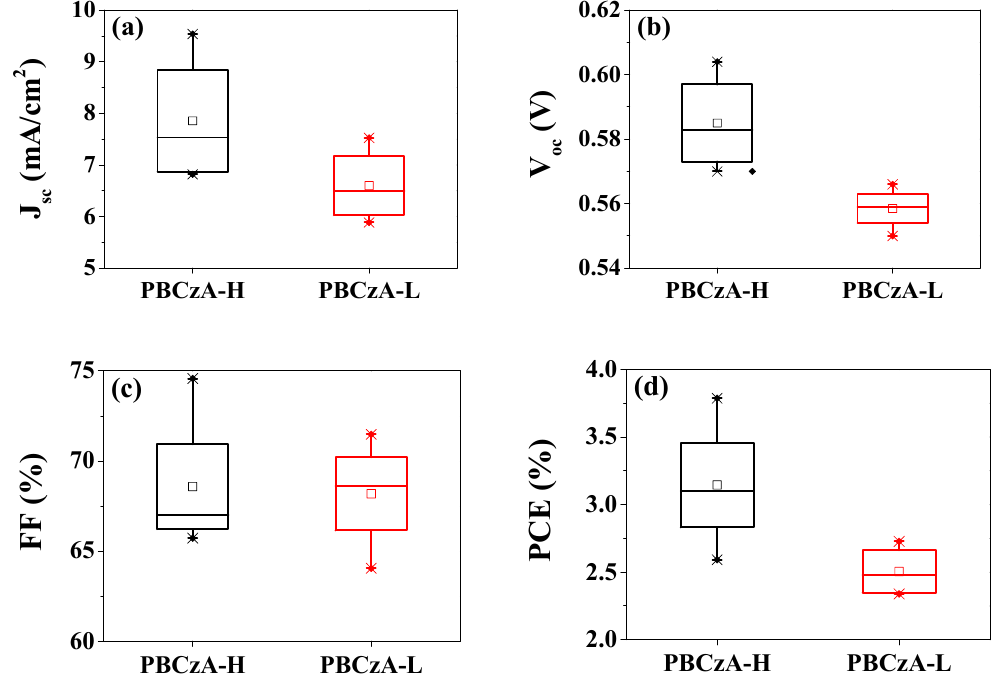
Figure 2. Comparison of photovoltaic parameters with molecular weights of PBCzA: ( a ) J sc , ( b ) V oc , ( c ) FF , and ( d ) PCE of the ssDSCs measured under AM 1.5 (100 mW/cm 2 ) illumination. Symbols x, − , □ stand for minimum or maximum, 1% or 99% and averaged values, respectively. The bottom and upper sides of the square indicate lower and upper quartiles, respectively.